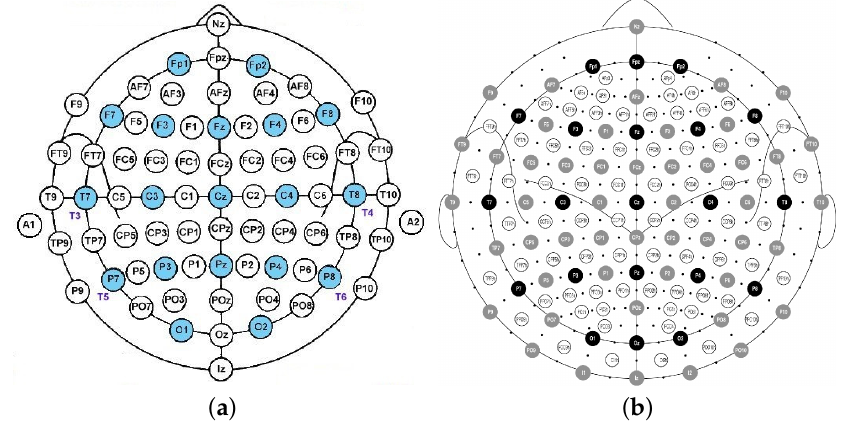
Figure 2. ( a ) Electrode positions in the 10–10 system; light blue circles denote the 10-20 electrode positions. ( b ) Electrode positions in the 10-5 system; dots indicate the positions added to the 10–10